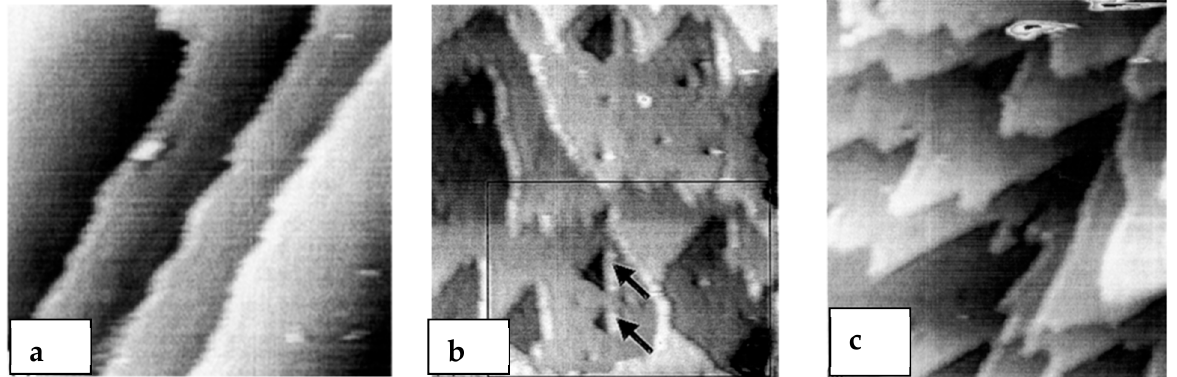
Figure 30. In situ STM observation of the surface of n-Si(111) in 2 M NaOH solution under relatively strong hydrogen evolution of 200 µA/cm 2 ( a ) Image (380 × 380 Å 2 ) of the starting material. The following tunneling conditions: U S = − 0.63 V/Pd-H; I S = − 150 µa/cm 2 ; tip: U T = +300 mV/Pd; IT = 0.2 nA ( b ) Image (1076 × 1193 Å 2 ) of the growth of triangular etch pits which is followed by their coalescence. The following tunneling conditions: U S = − 0.63 V/Pd-H; I S = − 150 µa/cm 2 ; tip: UT = +300 mV/Pd; IT = 0.2 nA ( c ) Image (1280 × 1470 Å 2 ) at the end of corrosion under the same tunneling conditions as ( b ) and terraces go upwards from the bottom left to the upper right. Reprinted with permission from Reference [94]. Copyright 1992 Elsevier.